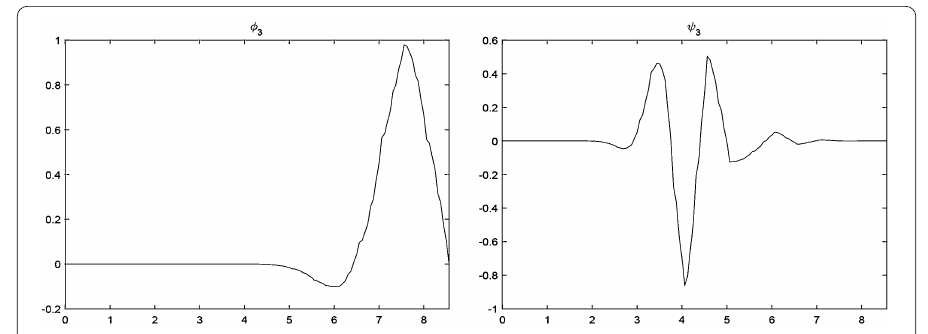
Figure 1 φ 3 ( x ) and ψ 3 ( x ) from Example